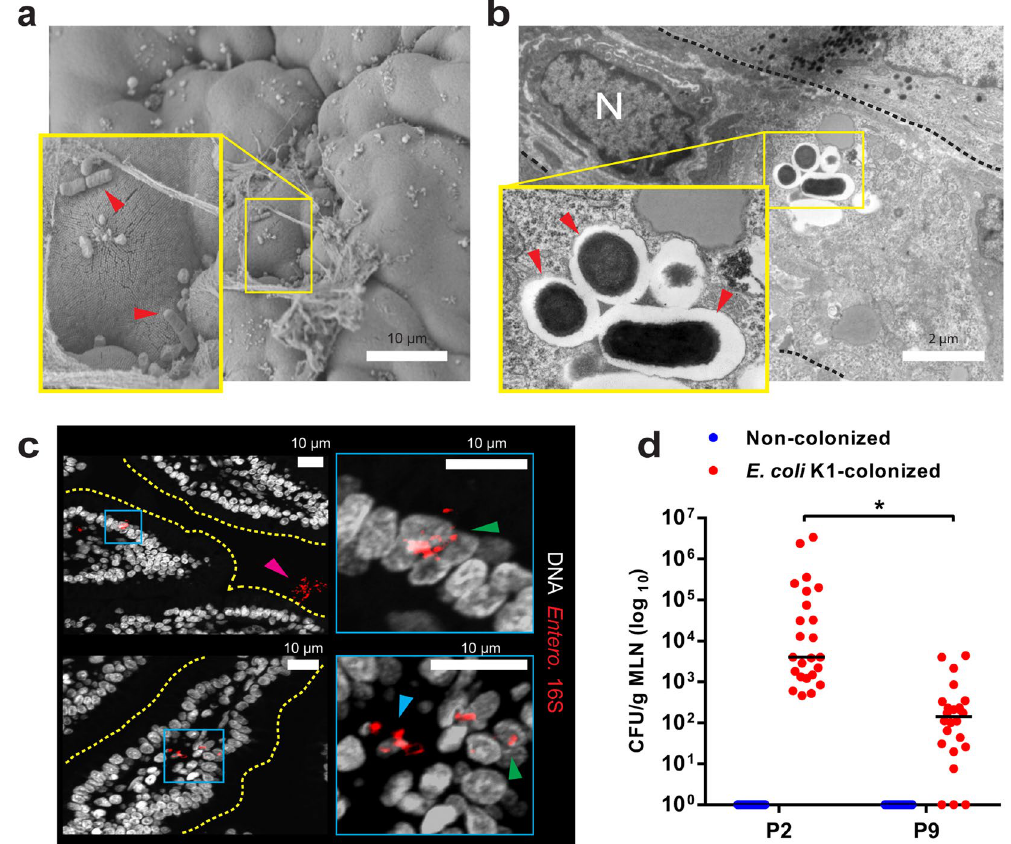
Figure 4. E. coli K1 invasion of the MSI epithelium results in translocation of live bacteria to the intestinal mesenteric lymph nodes ( a ) SEM of MSI tissue from neonates 24 h after E. coli K1 colonization at P2; tissue-associated bacteria indicated ( ). ( b ) TEM of MSI enterocytes 24 h after E. coli K1 colonization at P2; intracellular bacteria within vesicles ( ), enterocyte nucleus (N) and cell border (black dashed line) are indicated. ( c ) Confocal micrographs of MSI sections from neonatal rats 24 h after E. coli K1 colonization at P2; sections stained for Enterobacteriaceae 16S rRNA (red) and DNA (grey); right panel shows magnified images of regions defined by blue insets in left panels; luminal ( ), intracellular ( ) and translocated ( ) bacteria are indicated. ( d ) Bacterial load within mesenteric lymphatic node tissue (MLN) harvested from P2 and P9 rats 24 h after initiation of colonization with E. coli A192PP, showing enumeration of E. coli K1 (phage K1E-susceptible). n = 23 animals for non-colonised and n = 24 animals for colonized pups; line is median, * P < 0.05 (Student’s t